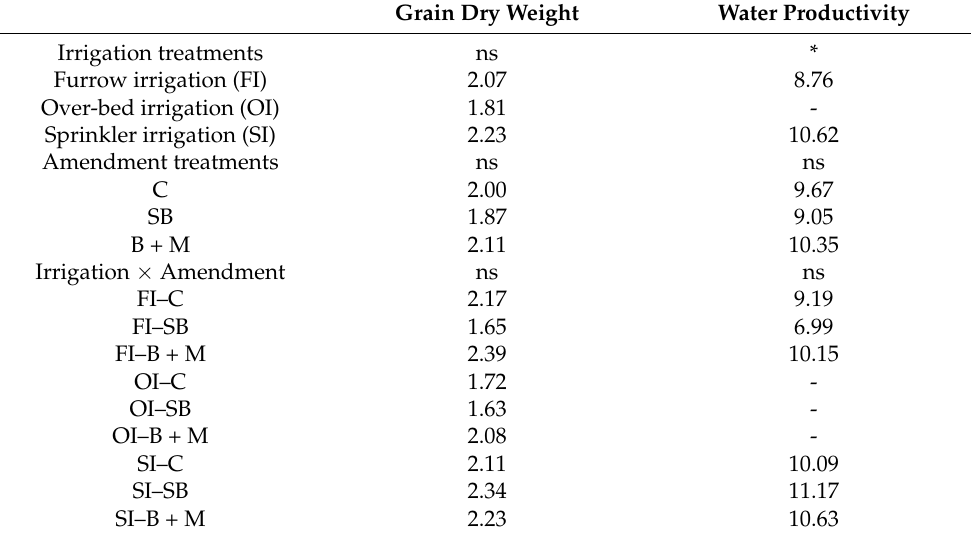
Table 10. Average grain yield (t ha − 1 ) and water productivity of maize for the irrigation and amendment (control (C), buried rice straw (SB) and biochar plus manure (B + M)) treatments and each combination of irrigation and amendment tested in experiment 5 during the 2017/18 dry season.